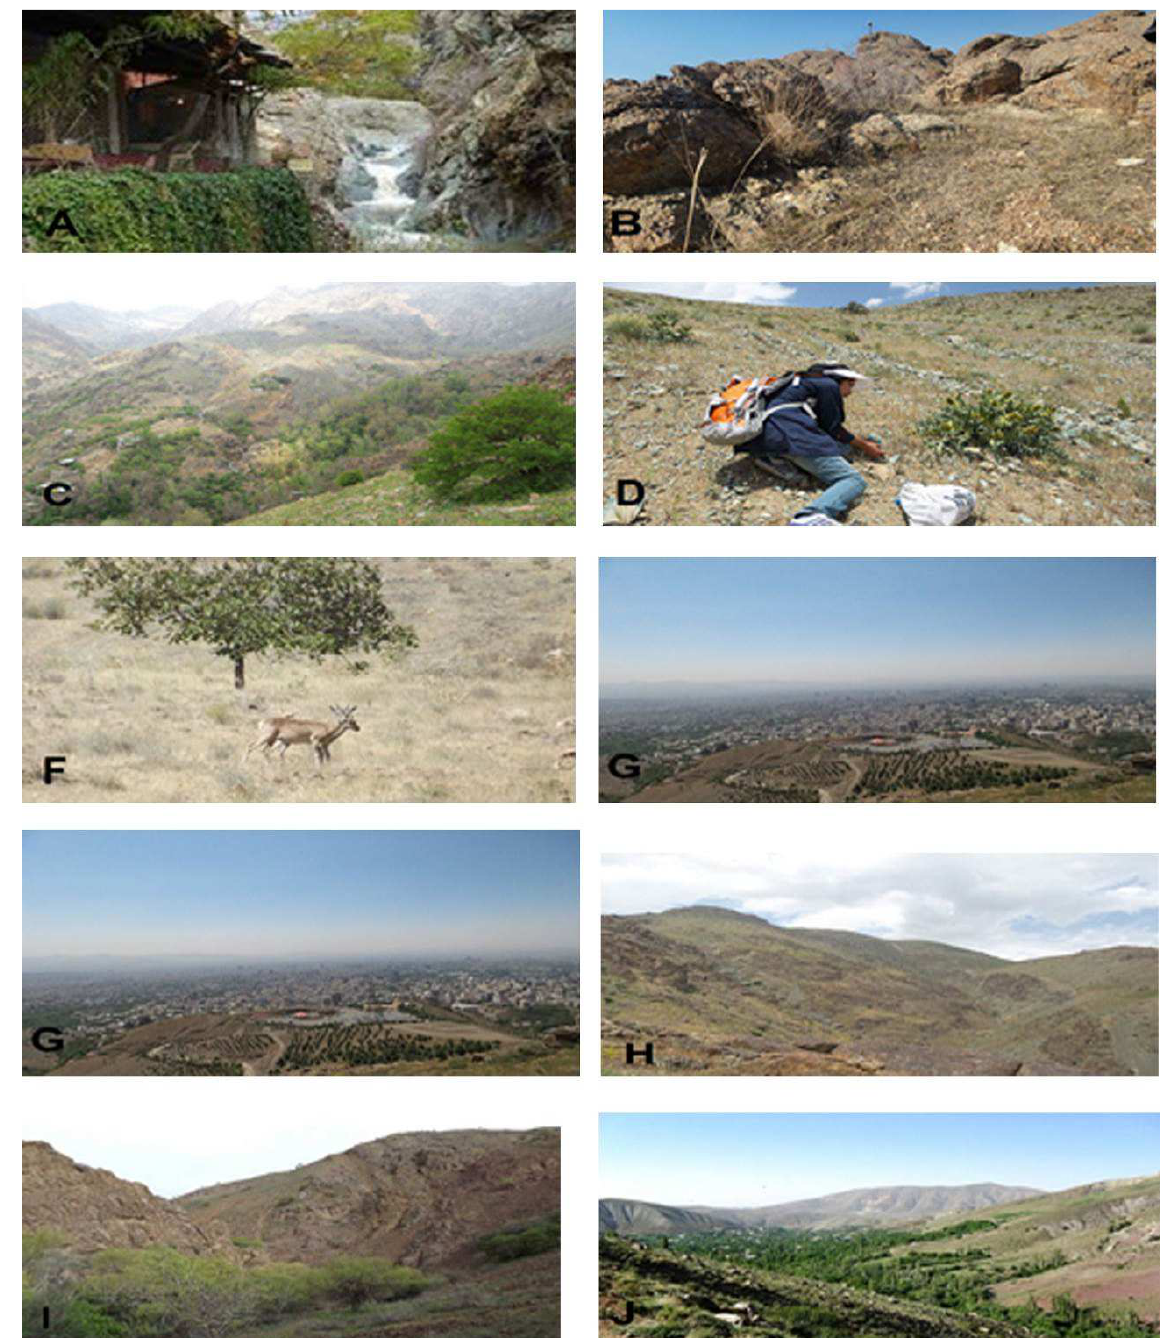
F IGURE 2. Collecting sites of Mantodea (for localities and details see Table